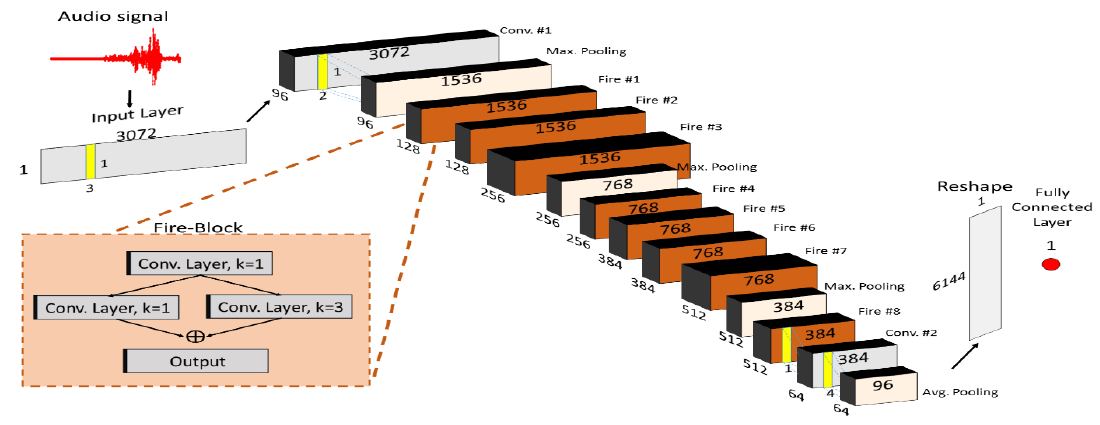
Figure 8. Architecture of the SqueezeNet based CNN model.